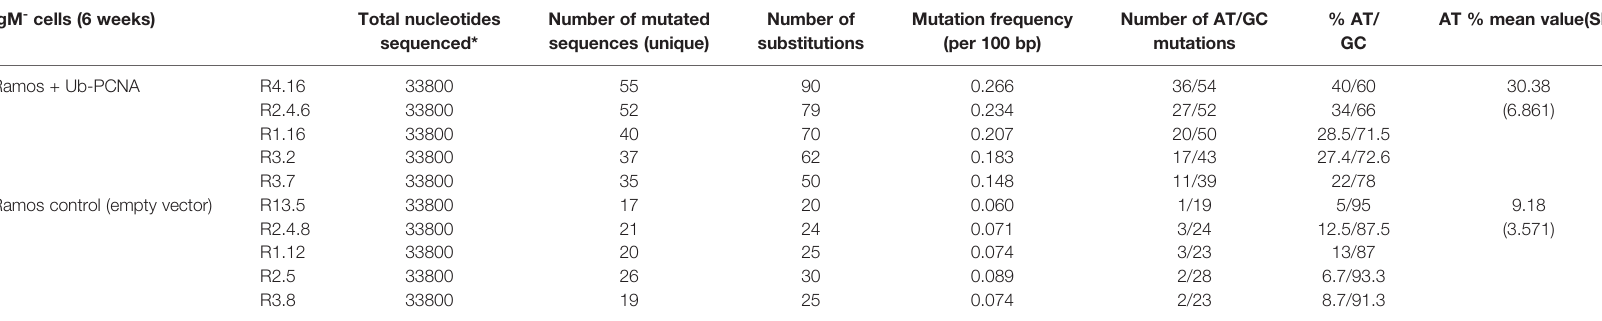
Number of mutated sequenced* sequences (unique)